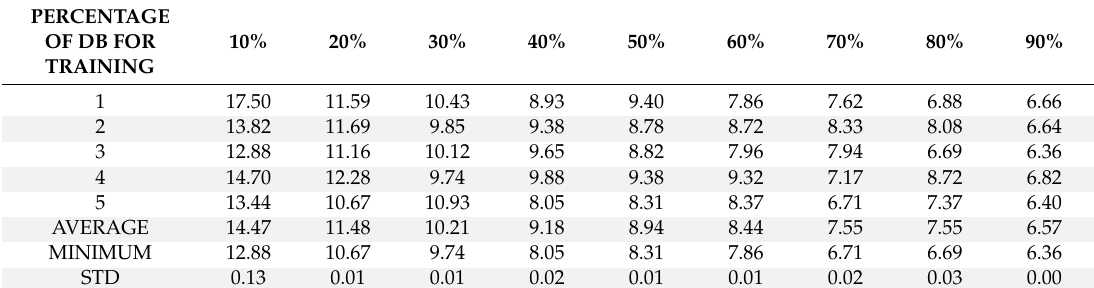
Table 4. Detailed EERs of the final algorithm, Rnn-1 F-64